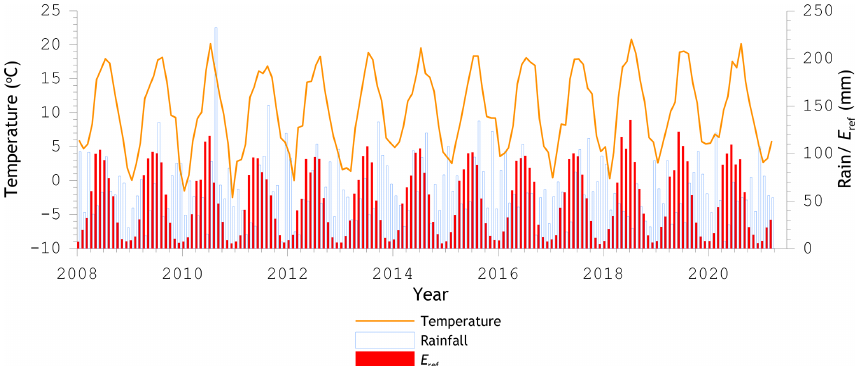
Figure 2. Monthly average of the daily mean 1.5m air temperature, and monthly rainfall and E ref sums derived as mean values from the measurements collected at the KNMI automated weather stations Heino, Hupsel, and